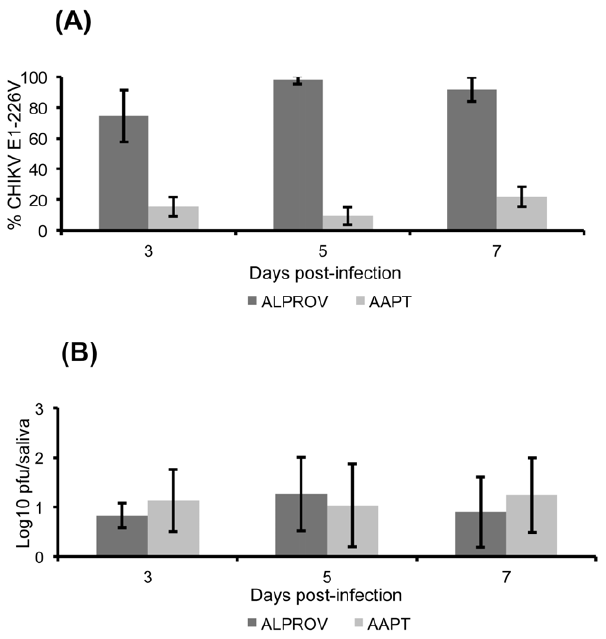
Figure 1. Effect of the E1-A226V substitution on CHIKV transmission in Ae.aegypti (AAPT) and Ae.albopictus (ALPROV). Ae. aegypti (light-grey) and Ae. albopictus (dark-grey) were orally infected with E1-226A and E1-226V provided at the same titer, 10 6.5 pfu/mL. At days 3, 5 and 7 post-infection, mosquitoes were prepared for salivation. Collected saliva was used to inoculate monolayers of Vero cells. After 3 days at 37 u C, clones were identified by sequencing. The proportion of E1-226V compared to E1-226A (A) and the number of infectious particles (B) were determined. Error bars show the confidence intervals (95%) for % CHIKV E1-226V and the standard deviations for Log10 pfu/midgut. doi:10.1371/journal.pone.0057548.g001 in Ae. albopictus midgut. When comparing proportions of E1-226V at a given day pi with the starting reference at day 0 pi for each mosquito species, significant increases were found from day 1 pi (Fisher’s exact test: p , 0.05) for ALPROV whereas differences were only detected at day 1 pi and day 6 pi (Fisher’s exact test: p , 0.05) for AAPT. (Figure 4A). For AAPT, proportions of E1-226V compared to E1-